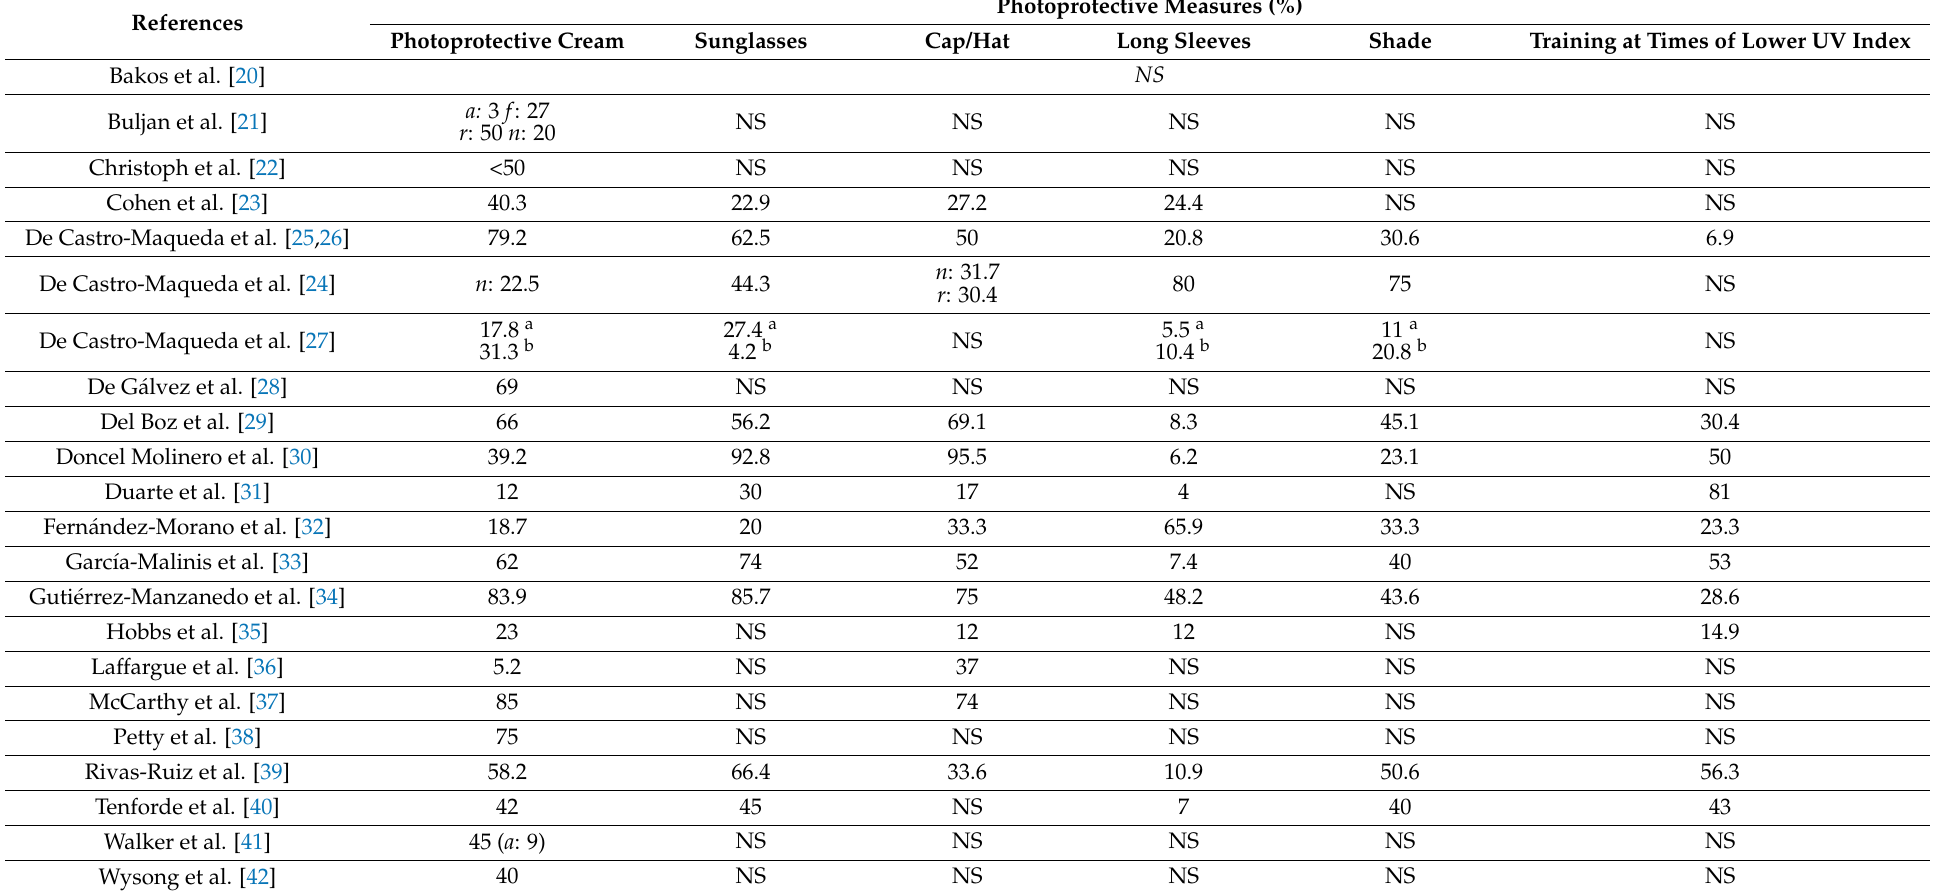
Table 2. Frequency of use of photoprotective measures by